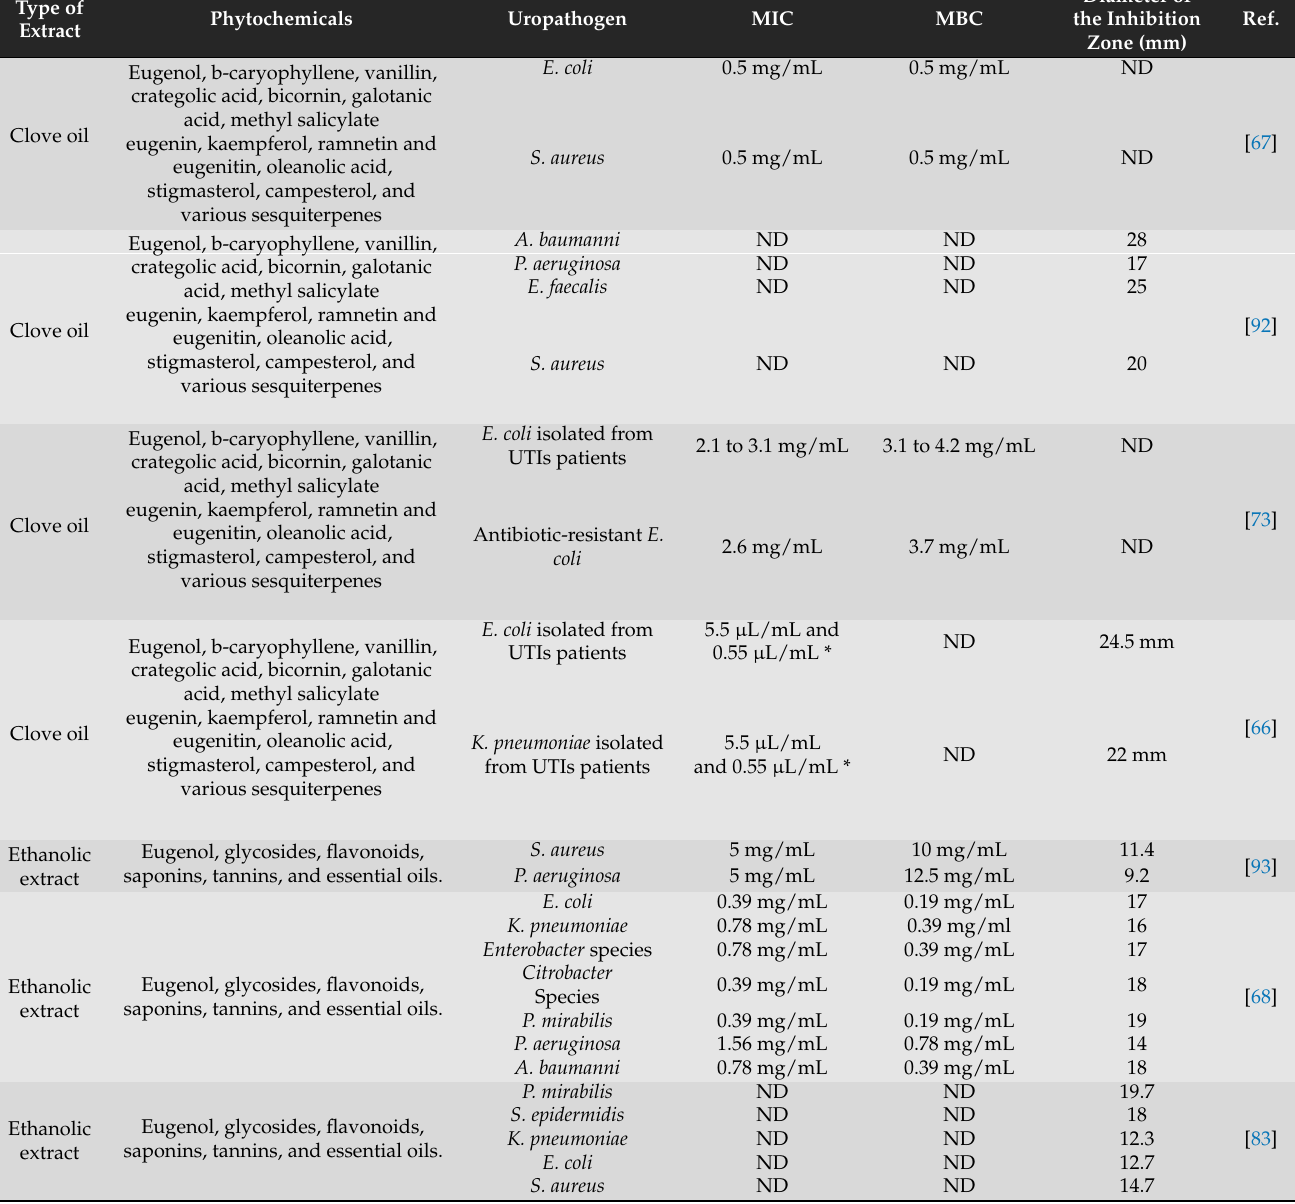
Table 2. Antimicrobial activity of S. aromaticum